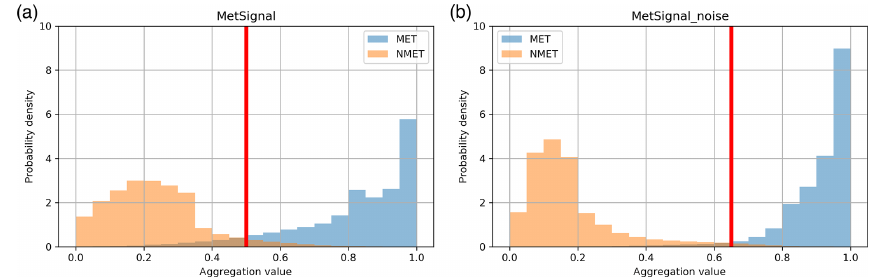
Figure 3. The normalized frequency distributions and thresholds of A MET : (a) MetSignal and (b) MetSignal_noise.